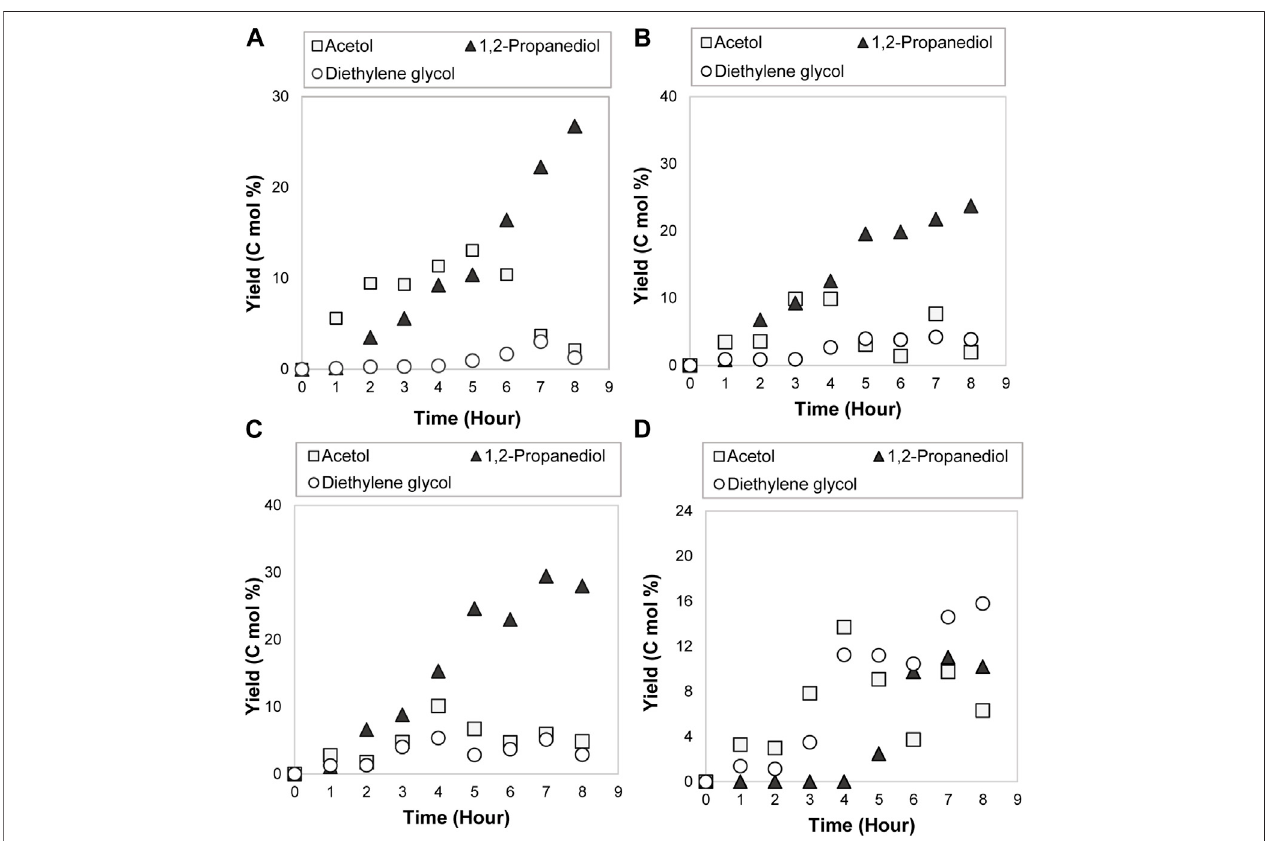
FIGURE 6 | Products distribution for 0.3 mol/L of glycerol electrocatalytic reduction at (A) 300 K, (B) 326.5 K, (C) 353 K and (D) 379.5 K with 0.14 A/cm 2 of current density.